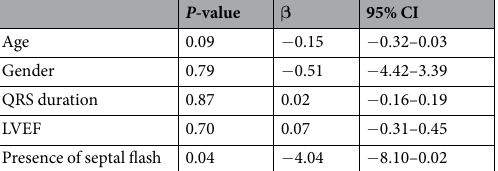
Table 3. Determinants of RV LS in LBBB patients with preserved LVEF. RV, right ventricle; LS, peak systolic longitudinal strain; LVEF, left ventricular ejection